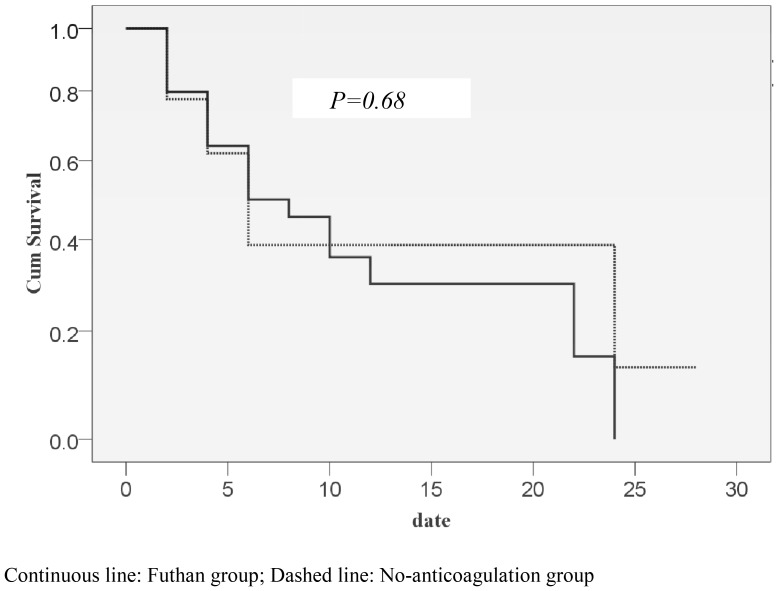
Survival curve of the Futhan group and No-anticoagulation group.